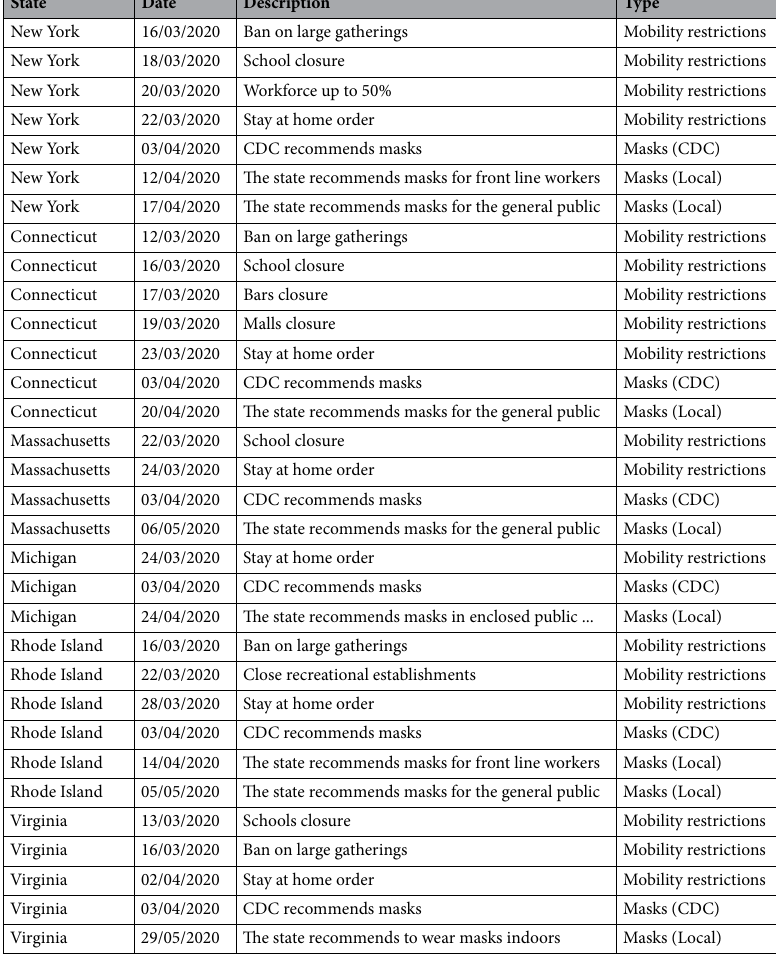
Table 2. Events by state and